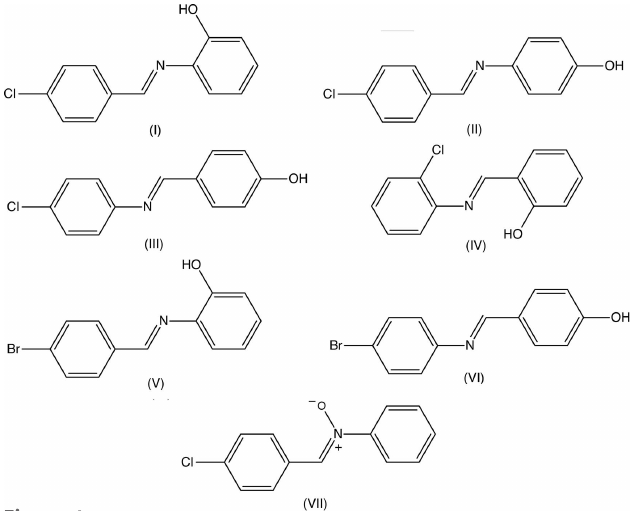
Figure 4 Compound (I) and some closely related analogues.